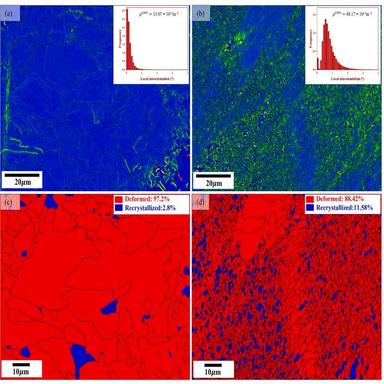
(a) and (b) the Kernel Average Misorientation (KAM) and (c and d) recrystallization fraction of ordinary of (a and c) plain stainless-steel and (b and d) its nanocomposite doped with 2.5 vol% of TiB2 nanoparticles.